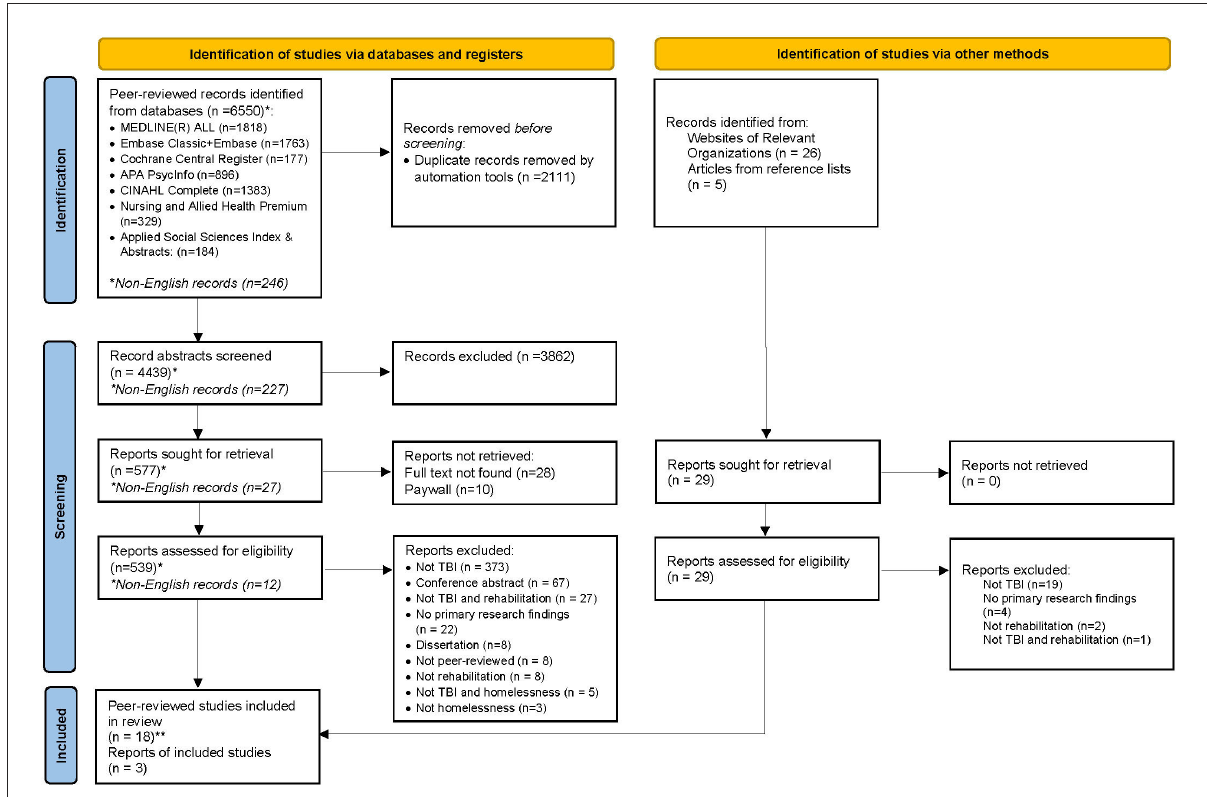
FIGURE1 PRISMA 2020 flow diagram for new systematic reviews which included searches of databases, registers, and other sources.